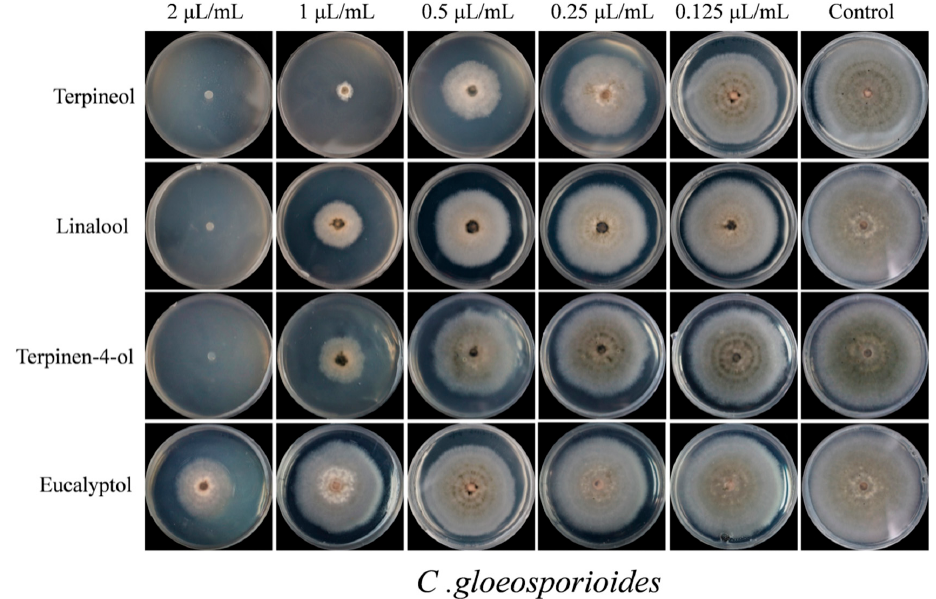
Figure 8. The mycelial growth of C. gloeosporioides after treatment by four mainly activity compounds with contact antifungal activity after 7 days.